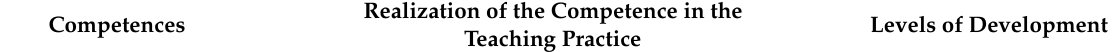
Table 2. Model for evaluation of teaching